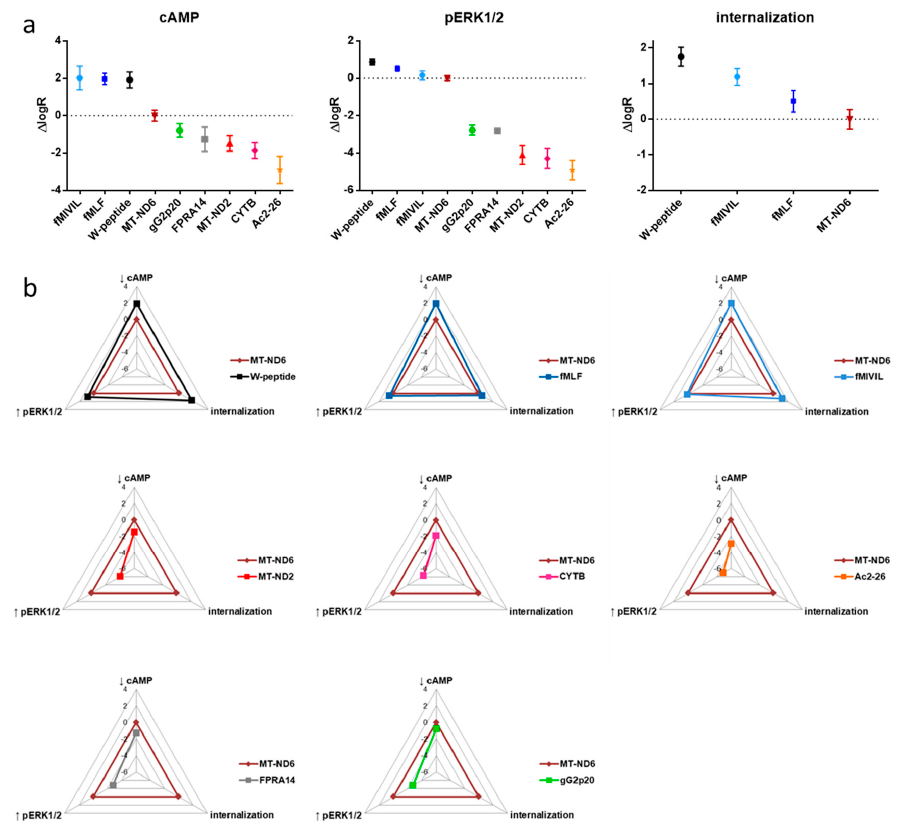
Figure 7. Relative agonist profiles compared to the endogenous reference agonist. ( a ) ∆ logR values were calculated from logR values with the mitochondrial peptide MT-ND6 as reference agonist. Data points represent the mean and 95% confidence intervals. ( b ) Relative agonist activities corresponding to the Δ logR values for the respective pathways are depicted in radial graphs. Each radius is displayed in the logarithmic scale. Cells 2020 , 9 , x FOR PEER REVIEW 11 of 19